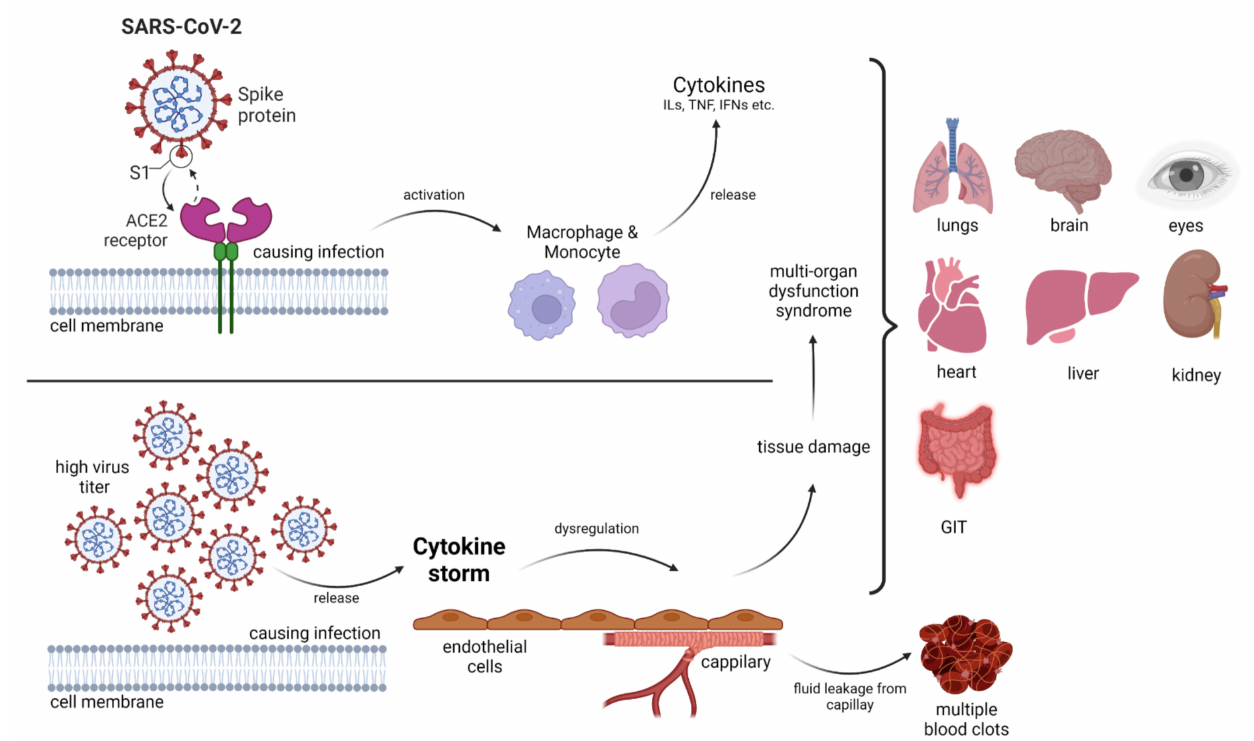
Figure 1. An overview of the SARS-CoV-2 infection pathway. During viral infection, immune cells are activated and release several cytokines as required for the biological system. A high virus titer is associated with a cytokine storm, and such dysregulation in the body of the patient may lead to multi-organ dysfunction syndrome. GIT—gastrointestinal